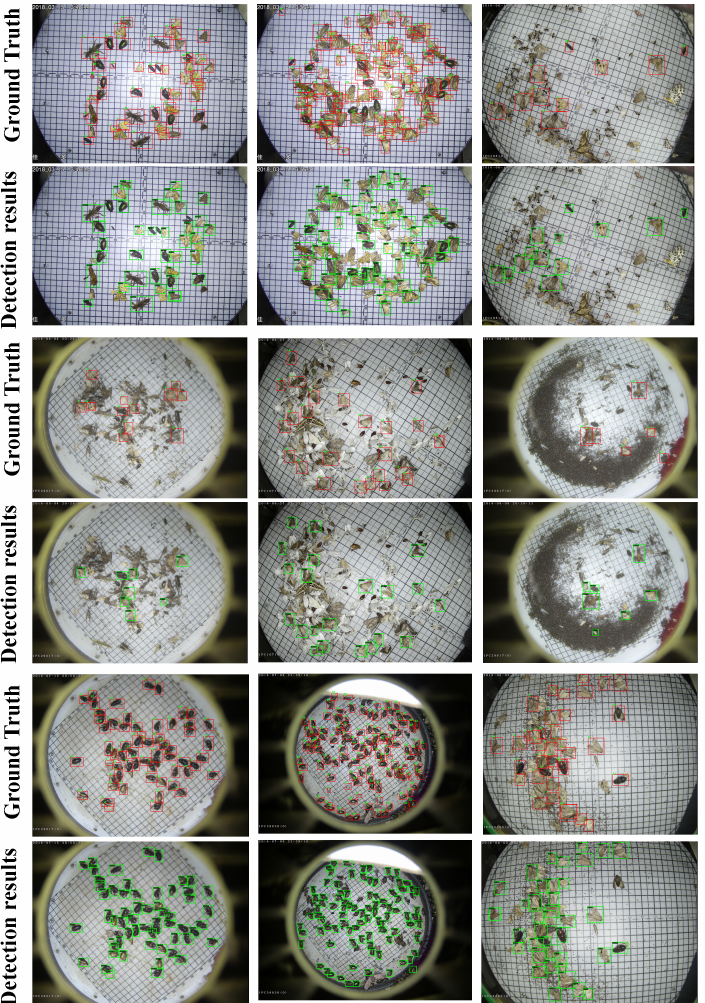
Figure 11. Detection results for each category on the MPD2021 dataset. Row 1, 3, and 5 are labeled boxes (red boxes); row 2 represents detection results of multi-category pest specimens per image; row 4 represents detection results in complex background images; row 6 represents the detection results of dense distribution